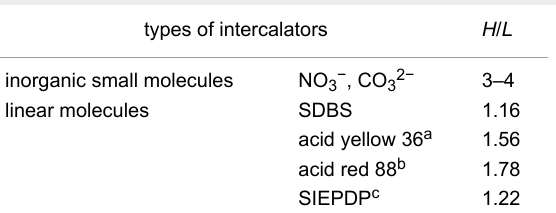
Table 1: Ratio between intergallery spacing and intercalator molecule size ( H / L ) of LDHs synthesized via the one-step route with Mg/Al (mol) = 2 [9,11,14].